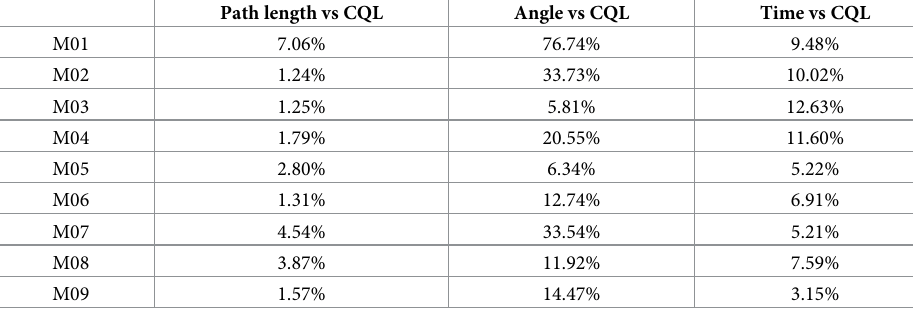
Table 4. Comparison of algorithm performance between SSQL and CQL in short path planning.